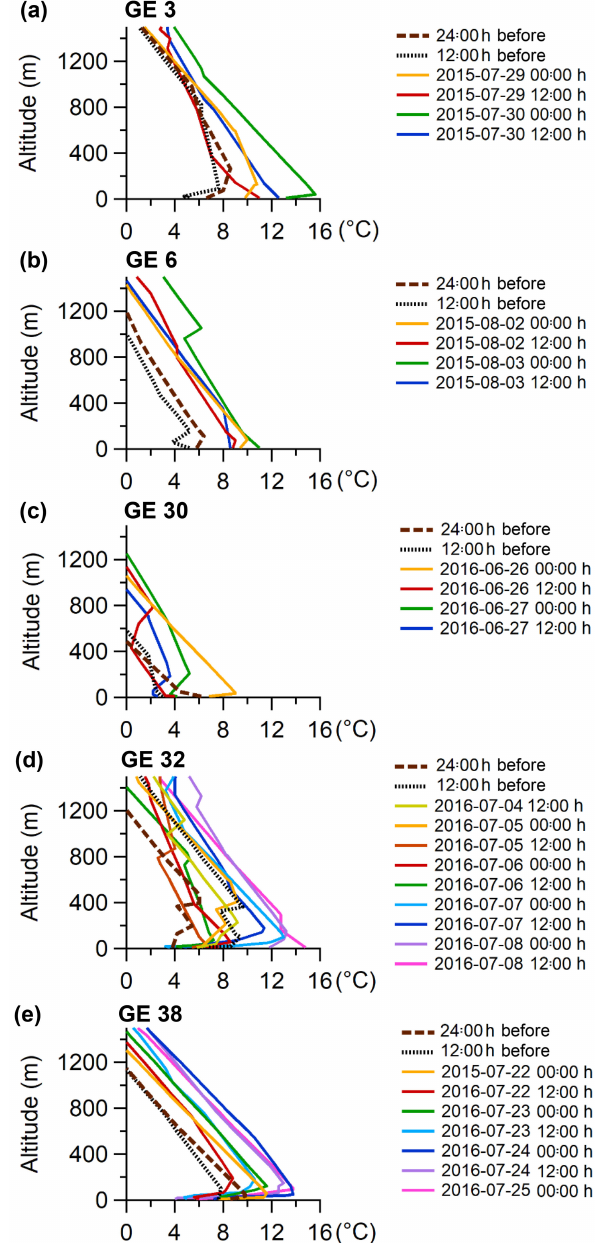
Figure 6. Vertical temperature profiles every 12h during the five selected growth events that are shown in the previous figure. Data include 24 and 12h prior to the start of the growth